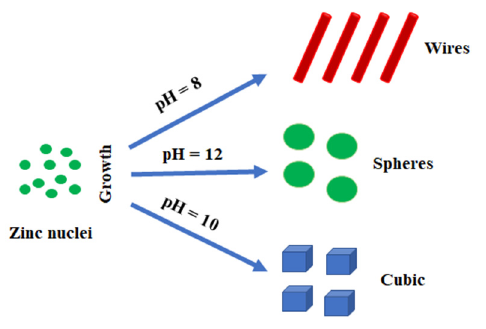
Figure 8. pH influence for morphology of zinc oxide nanoparticles.